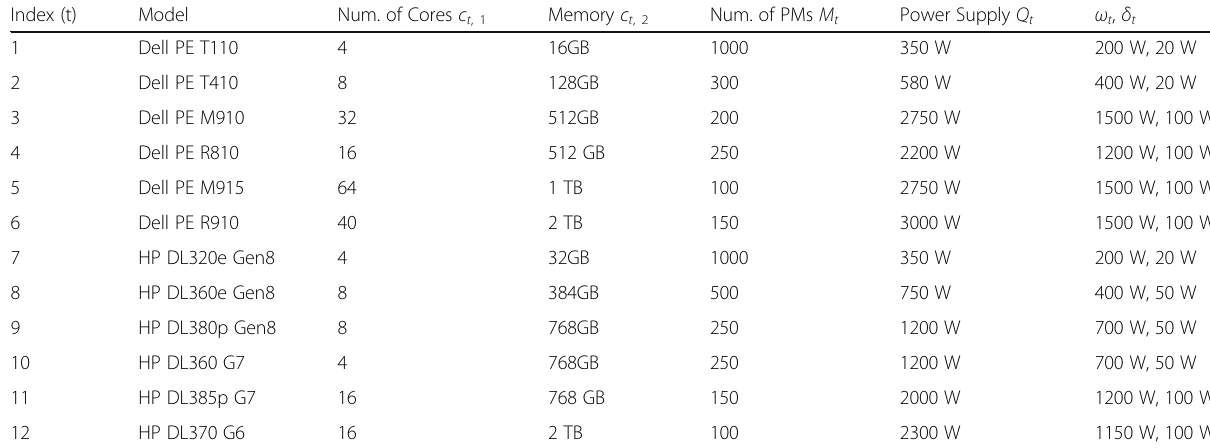
Table 3 Characteristics of Server types